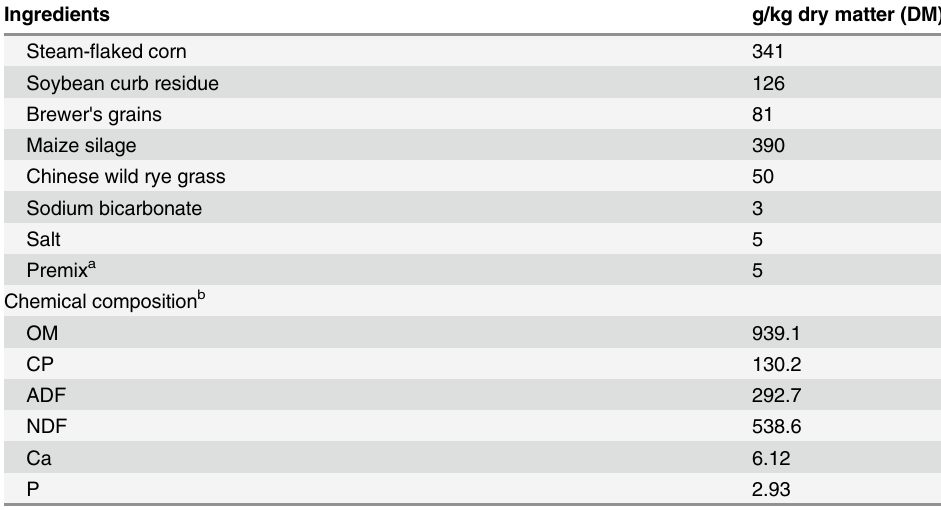
Table 1. The ingredients and chemical composition of the basal